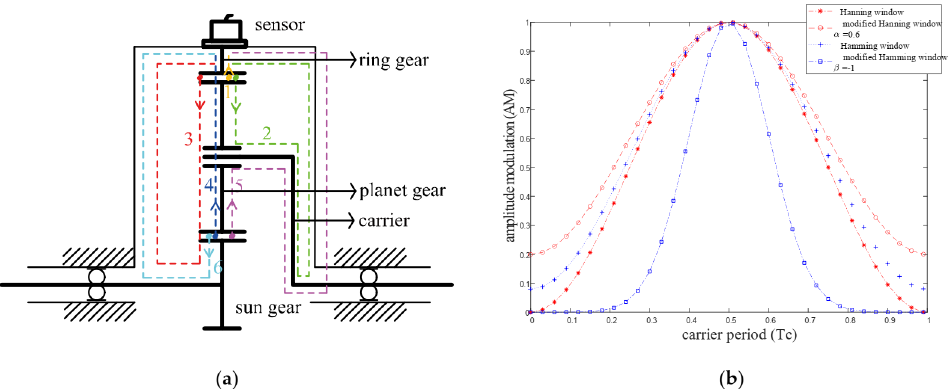
Figure 3. ( a ) Schematic diagram of vibration transfer paths in planetary gearbox ( b ) Modulation effect of different window